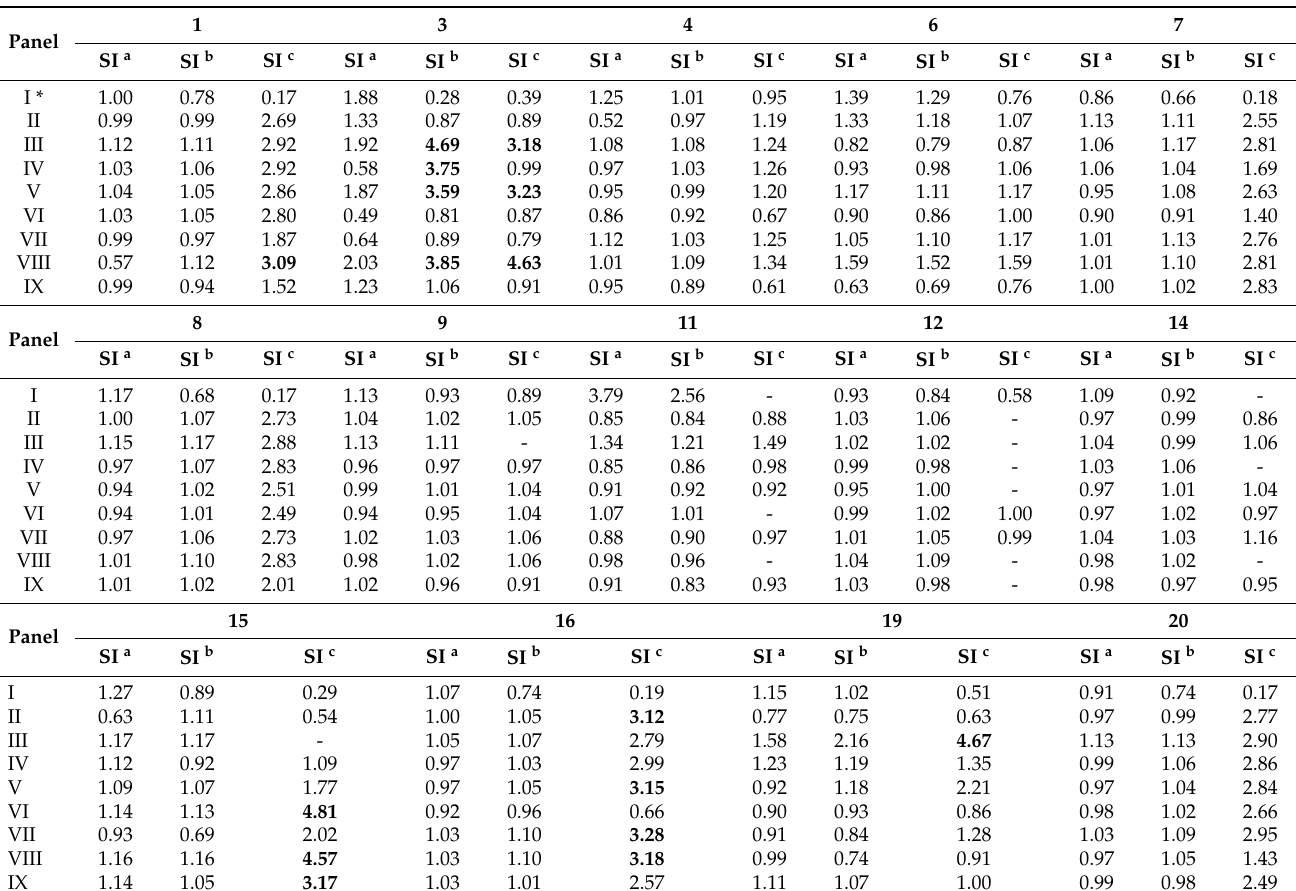
(Table S1 Supporting Material). Table 4. The selectivity indexes of compounds 1 , 3 , 4 , 6 , 7 – 9 , 11 , 12 , 14 – 16 , 19 , and 20 on the growth of tumor cell lines subpanel at the GI 50 , TGI, and LC 50 levels.